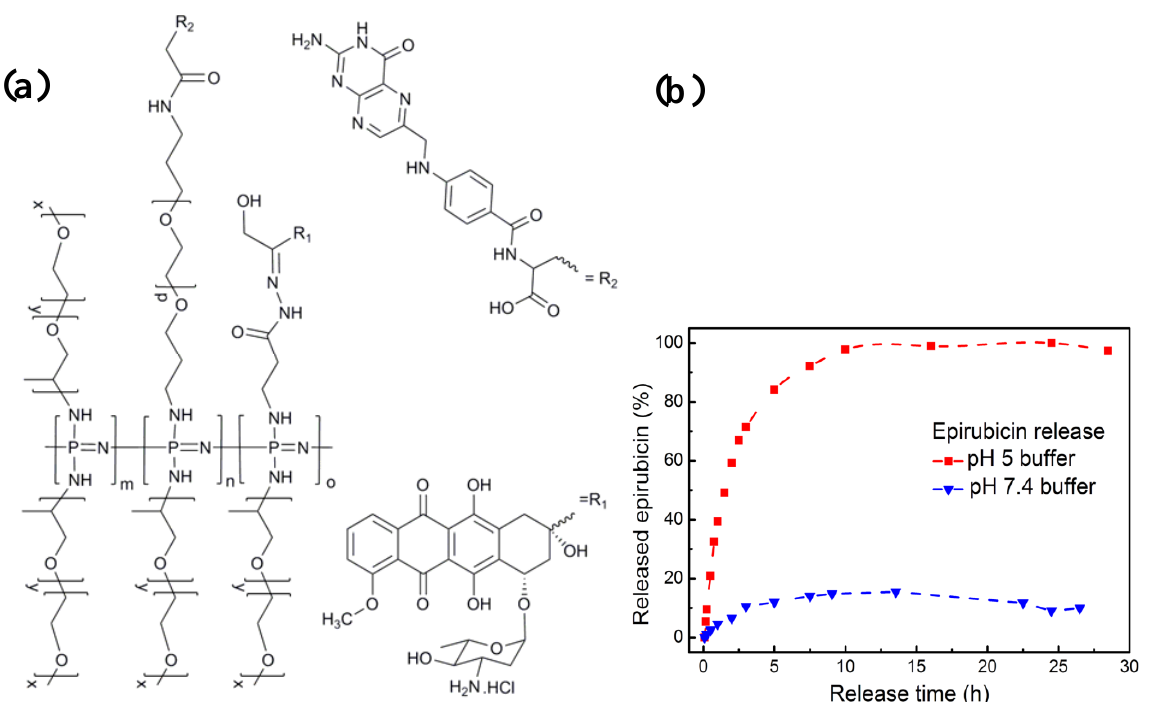
Figure 11. ( a ) Water soluble polyphosphazene loaded with a folic acid targeting ligands and epirubicin via a pH labile hydrazone bond. ( b ) Release of epirubicin from the hydrazone-linked polyphosphazene pH 5 ( ■ ) and pH 7.4( ▼ ). Originally published in [29] and reproduced by permission of The Royal Society of